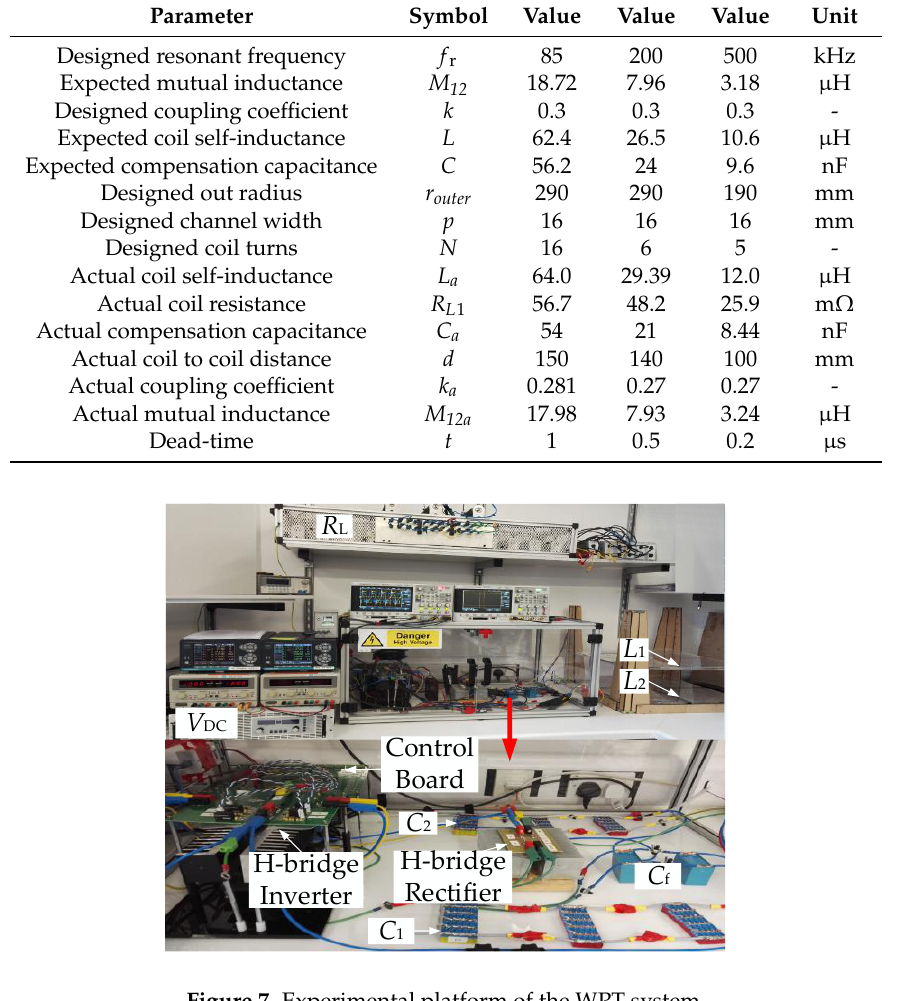
Figure 7. Experimental platform of the WPT system.